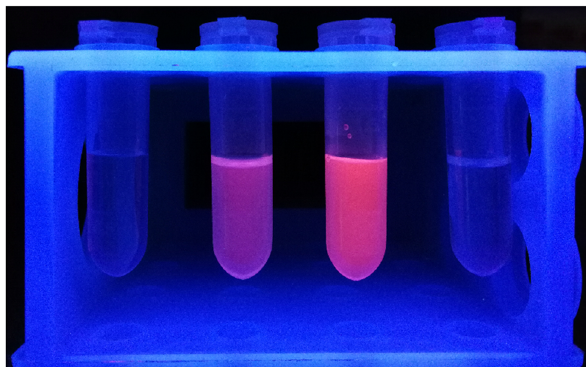
Figure 5: Photographs of water, Gd 2 O 2 S:Eu@PEG aqueous solution,